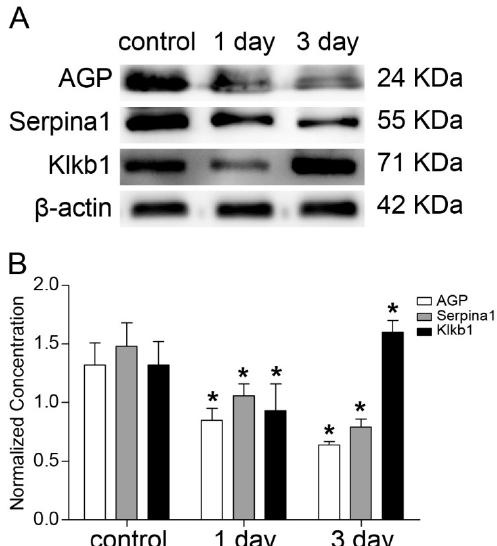
Figure 8. Protein–protein interaction networks of differentially expressed proteins in plasma tissues using the web-based tool STRING v10.5. Int. J. Mol. Sci. 2018 , 19 , x FOR PEER REVIEW